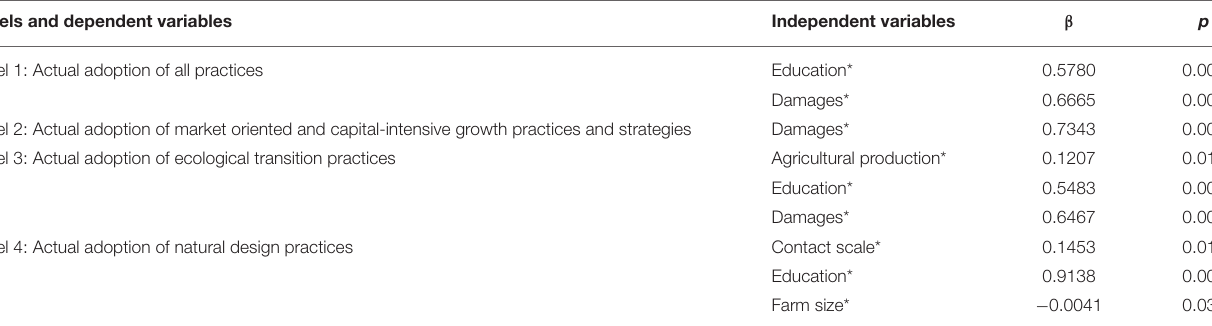
TABLE 6 | Significant results for four separate negative binomial regression models predicting actual adoption of farm and management practices. Models and dependent